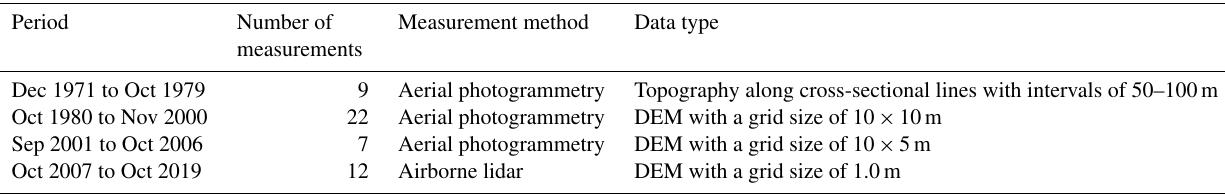
Table 1. General description of the aerial photogrammetry and airborne lidar measurements. Period Number of Measurement method Data type measurements Dec 1971 to Oct 1979 9 Aerial photogrammetry Topography along cross-sectional lines with intervals of 50–100m Oct 1980 to Nov 2000 22 Aerial photogrammetry DEM with a grid size of 10 × 10m Sep 2001 to Oct 2006 7 Aerial photogrammetry DEM with a grid size of 10 × 5m Oct 2007 to Oct 2019 12 Airborne lidar DEM with a grid size of